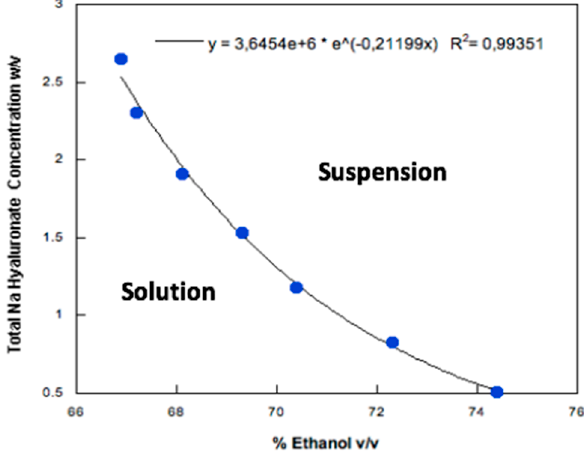
Figure 2. Sodium hyaluronate concentration in a water / ethanol mixture as a function of the ethanol volume necessary to obtain the inflection point in turbidimetric analysis.